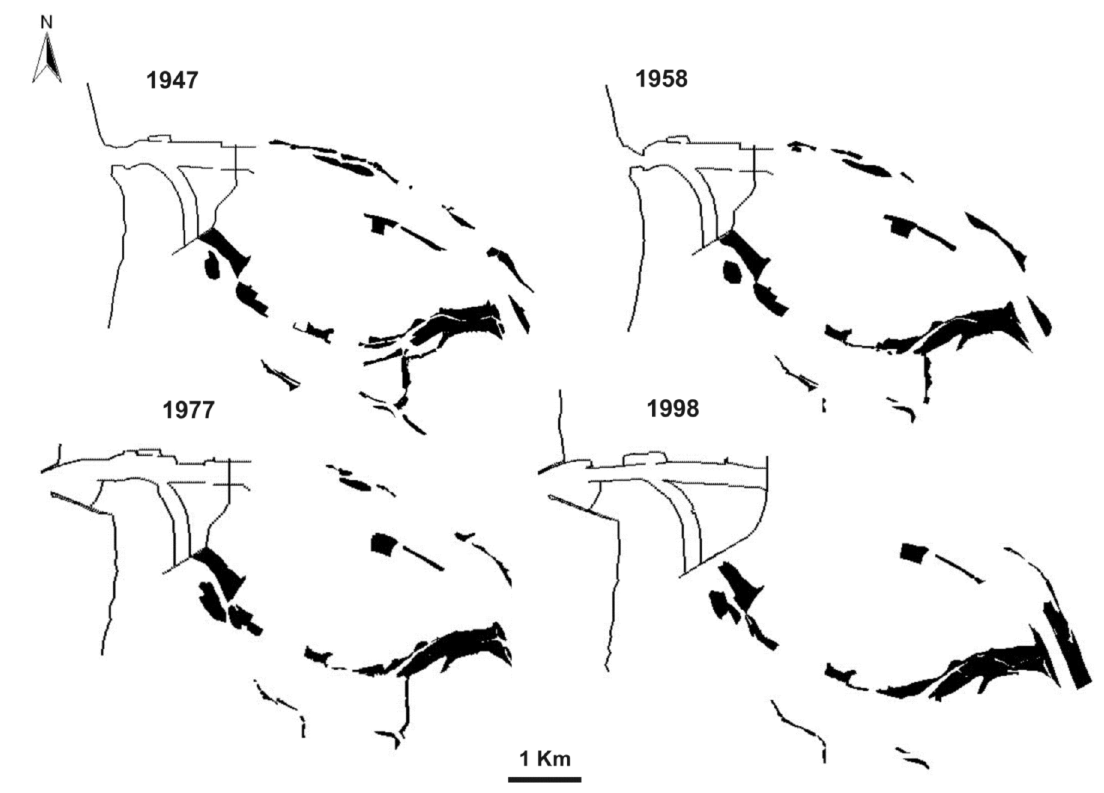
Fig. 4. Salt marsh distribution in the Mondego